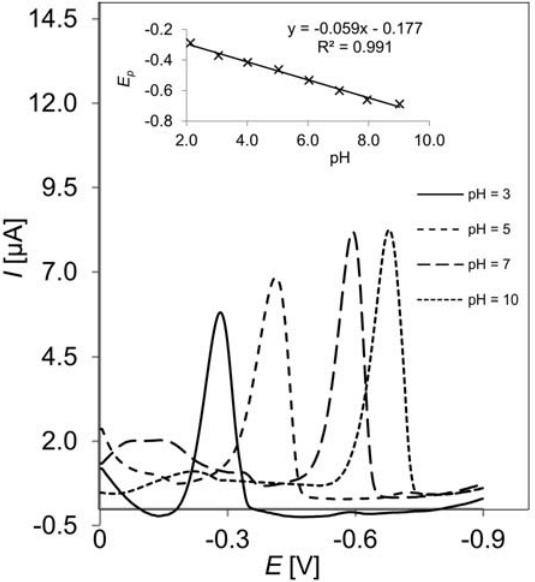
Figure 1. Voltammograms of 5 × 10 –7 mol L –1 aclonifen solution recorded in BR buffers with the following experimental conditions: = 25 mV, Δ E = 5 mV, f = 50 Hz; Inset: relations- SW amplitude E sw hip between pH and aclonifen peak potential.